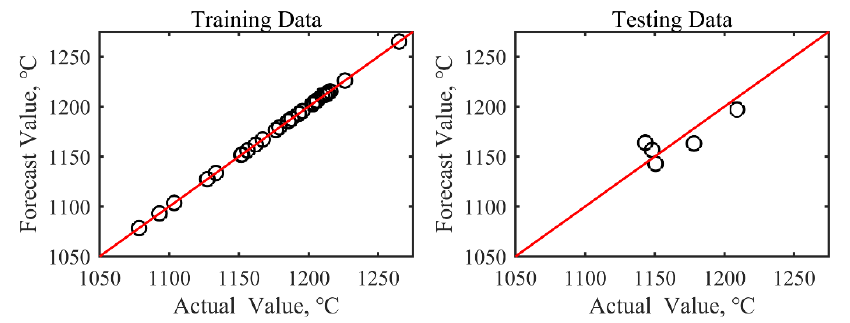
Figure 7. Actual value and forecast value of T sp 1.